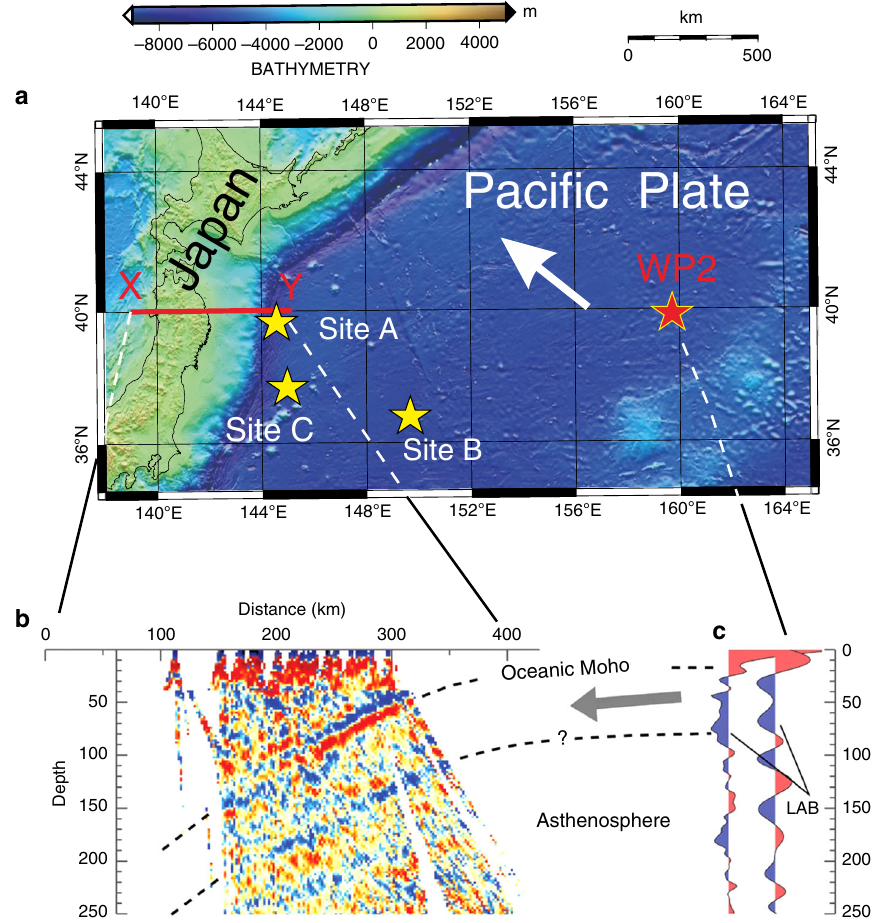
Fig. 1 Bathymetric maps for NW Paci fi c showing the position of the petit-spot volcanoes investigated in this study and the RF image of the subducting Paci fi c plate beneath northeast Japan. a Sites A, B, and C showing the location of petit-spot basalts. WP2 is a sea fl oor borehole station and the white arrow indicates the moving direction of the Northwestern Paci fi c plate. b P-RF image along the pro fi le X – Y using dense land seismic data of Hi-net from Japan, adapted from ref. 6 Reprinted with permission from AAAS. The two dashed lines show the oceanic Moho and the oceanic LAB, respectively. The red and blue colors indicate a velocity increase (from shallow to deep) and decrease at the point,